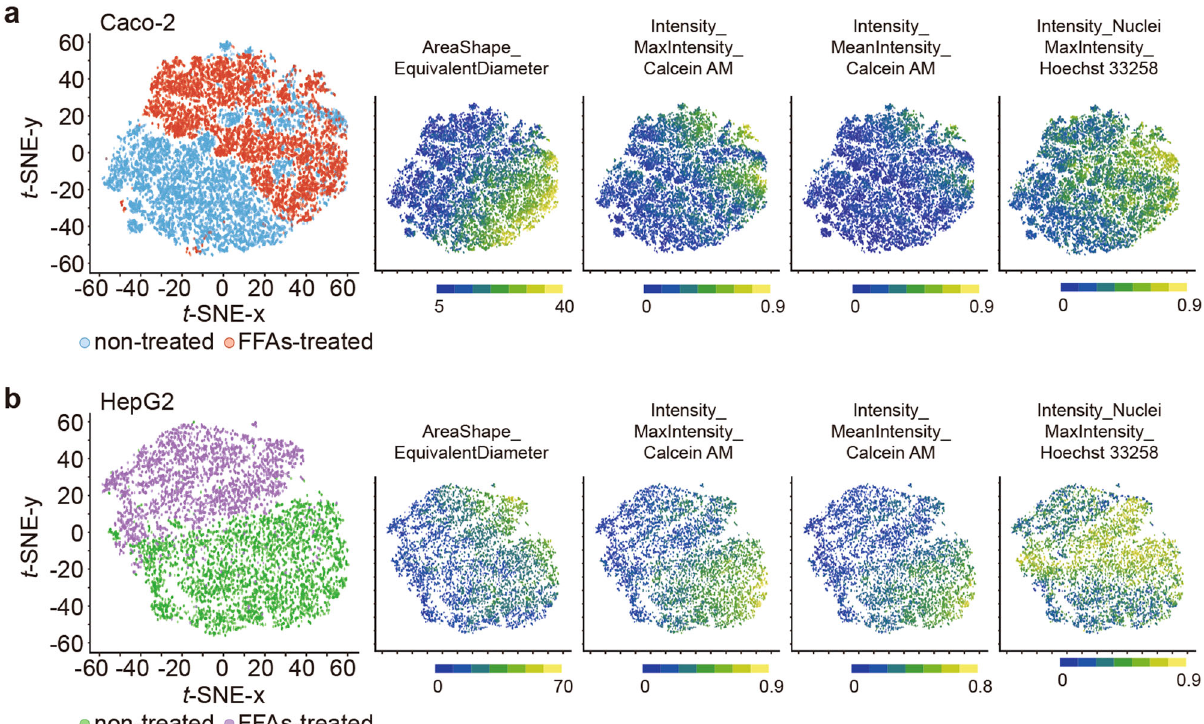
Fig. 5 Single-cell pro fi ling for the t-SNE analysis. a , b Two-dimensional t-SNE plots of microscopic single-cell pro fi ling of co-cultured Caco-2 ( a ) and HepG2 ( b ) treated with 1 mM of FFAs or no treatment and stained with Calcein AM cellular and Hoechst 33258 nuclei markers ( n = 3). The most distinguishable cellular parameters (AreaShape_EquivalentDiameter, Intensity_MaxIntensity_Calcein AM and Intensity_MaxIntensity_Hoechst 33258) are shown in the corresponding t-SNE plots, as well as the boxplots in Supplementary Fig. S11. The p -values are presented in Supplementary Tables S11,